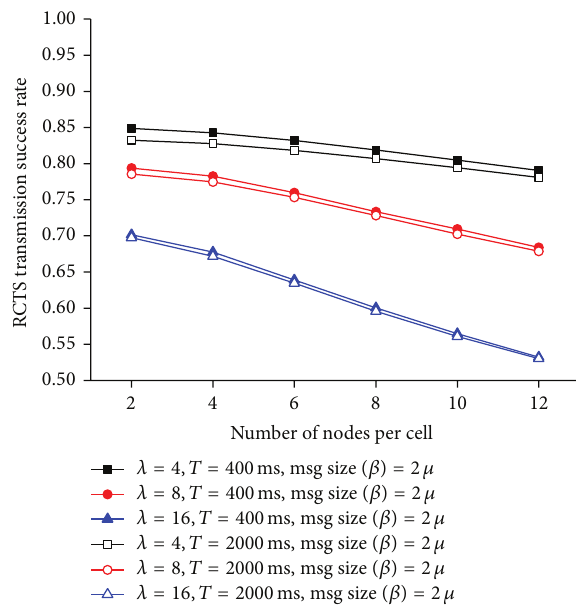
Figure 9: Resource reservation success rate in a mobile ad hoc environment ( 𝜆 = 16